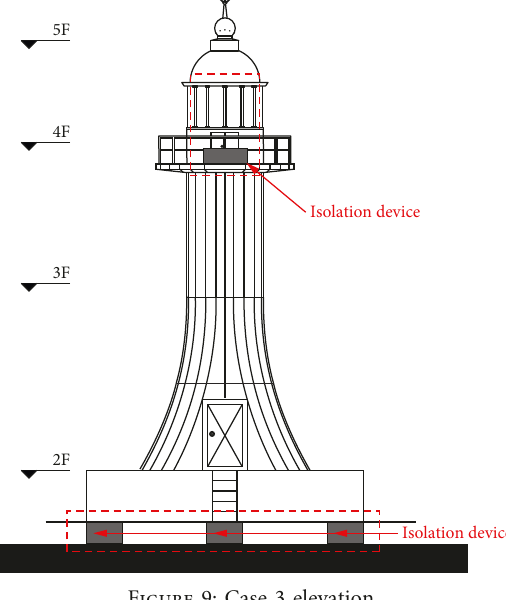
Figure 9: Case 3 elevation.